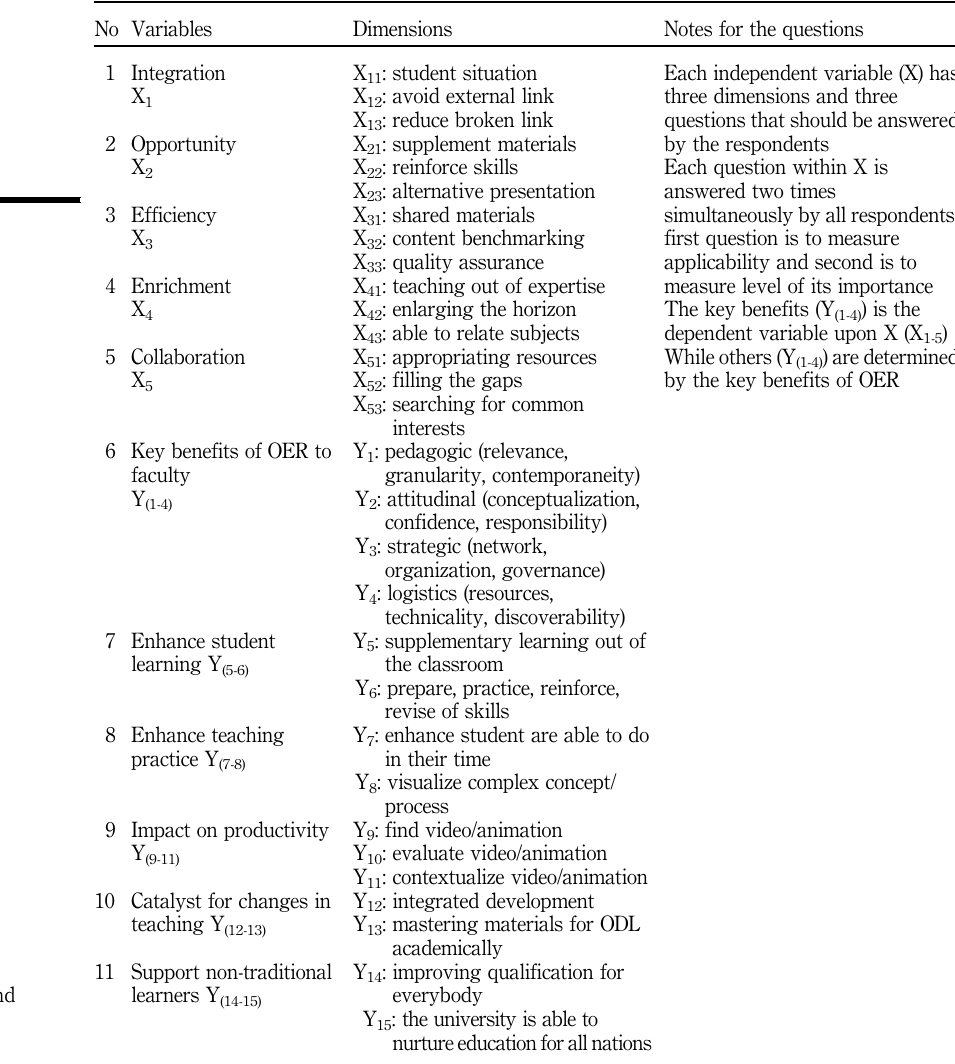
Table I and Figure 2 listed the highlights that influencing the key benefits of OER lead to enhance student learning, enhance teaching practice, impact on productivity, catalyze for changes in teaching practice, and support non-traditional learners. The benefits have the following attributes: pedagogic (relevance, granularity, and contemporaneity), attitudinal (conceptualization, confidence, and responsibility), strategic (network, organization, and governance), and logistics (resources, technicality, and discoverability). The key benefits (Y) were assessed by perceiving attributes of: enhance student